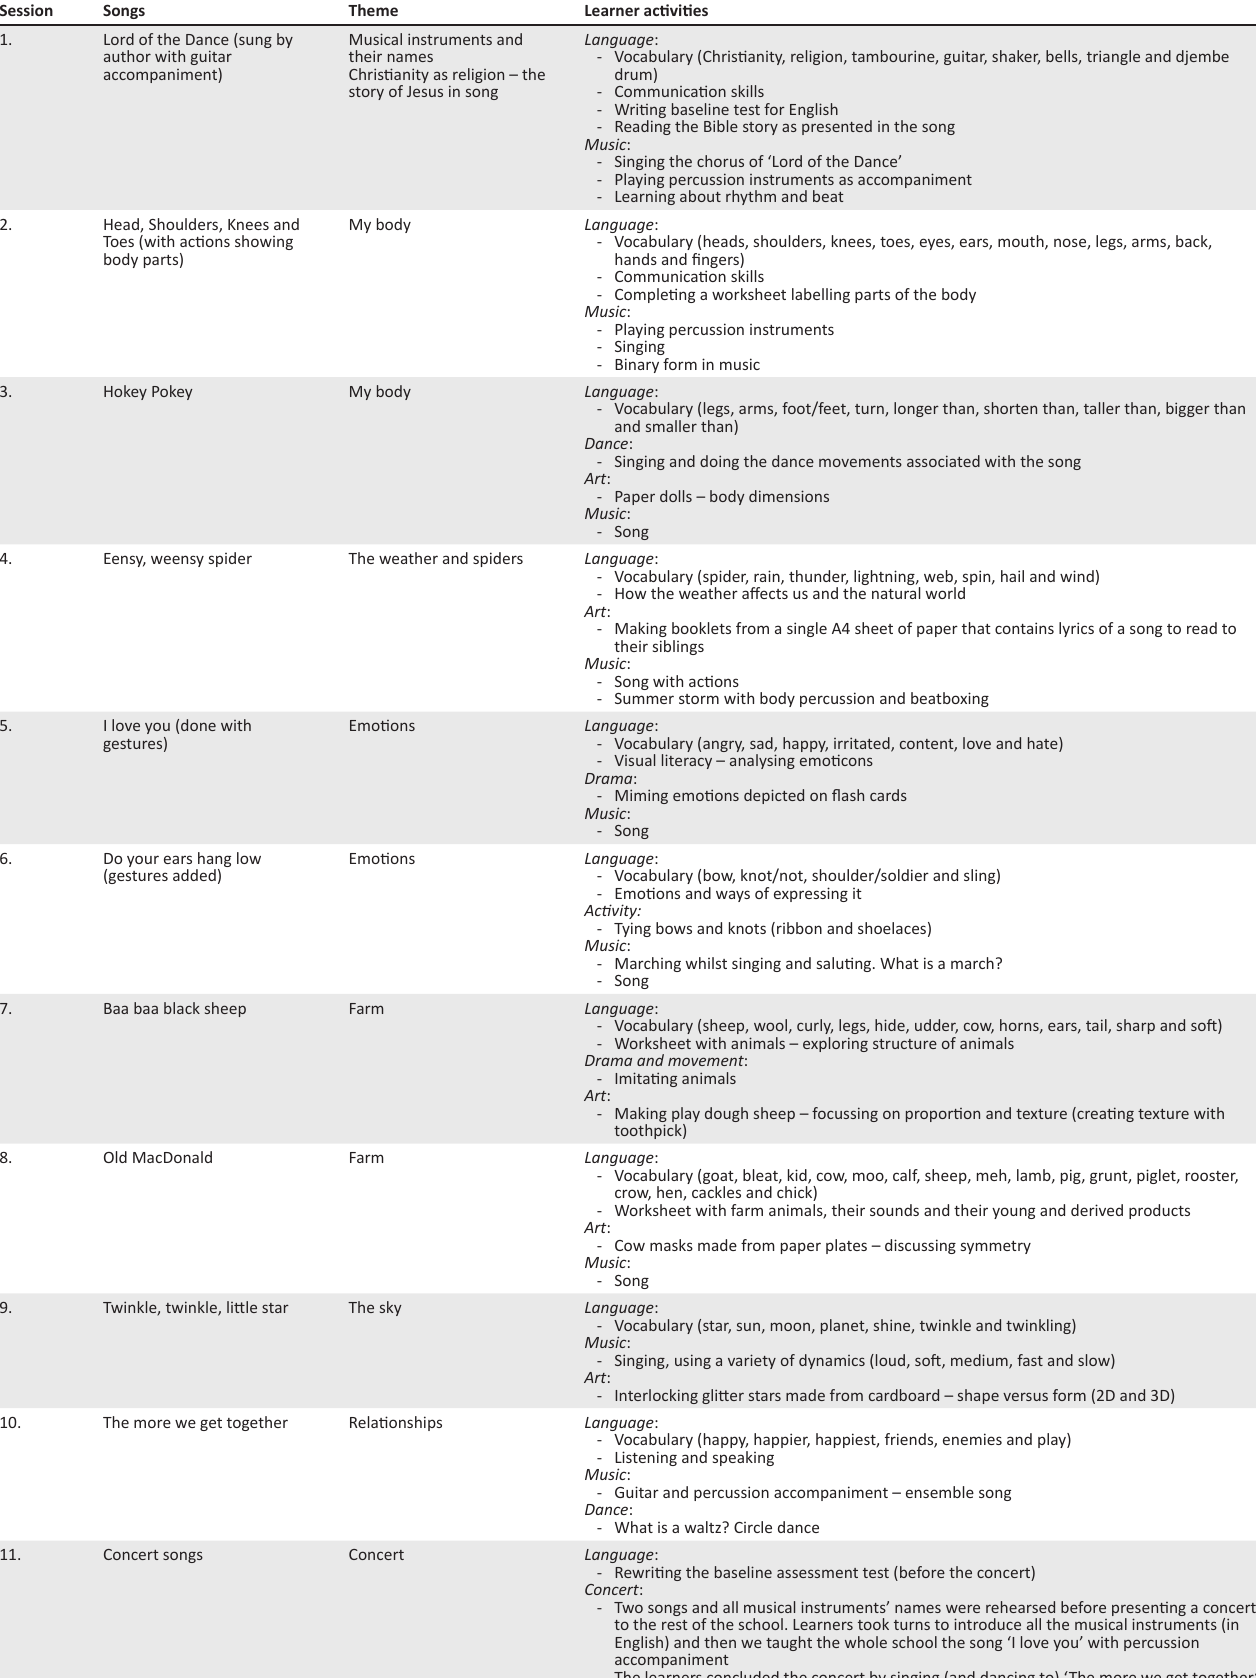
TABLE 1: Programme outline showing the content of arts-integrated sessions with Grade 4 class in rural Zululand.